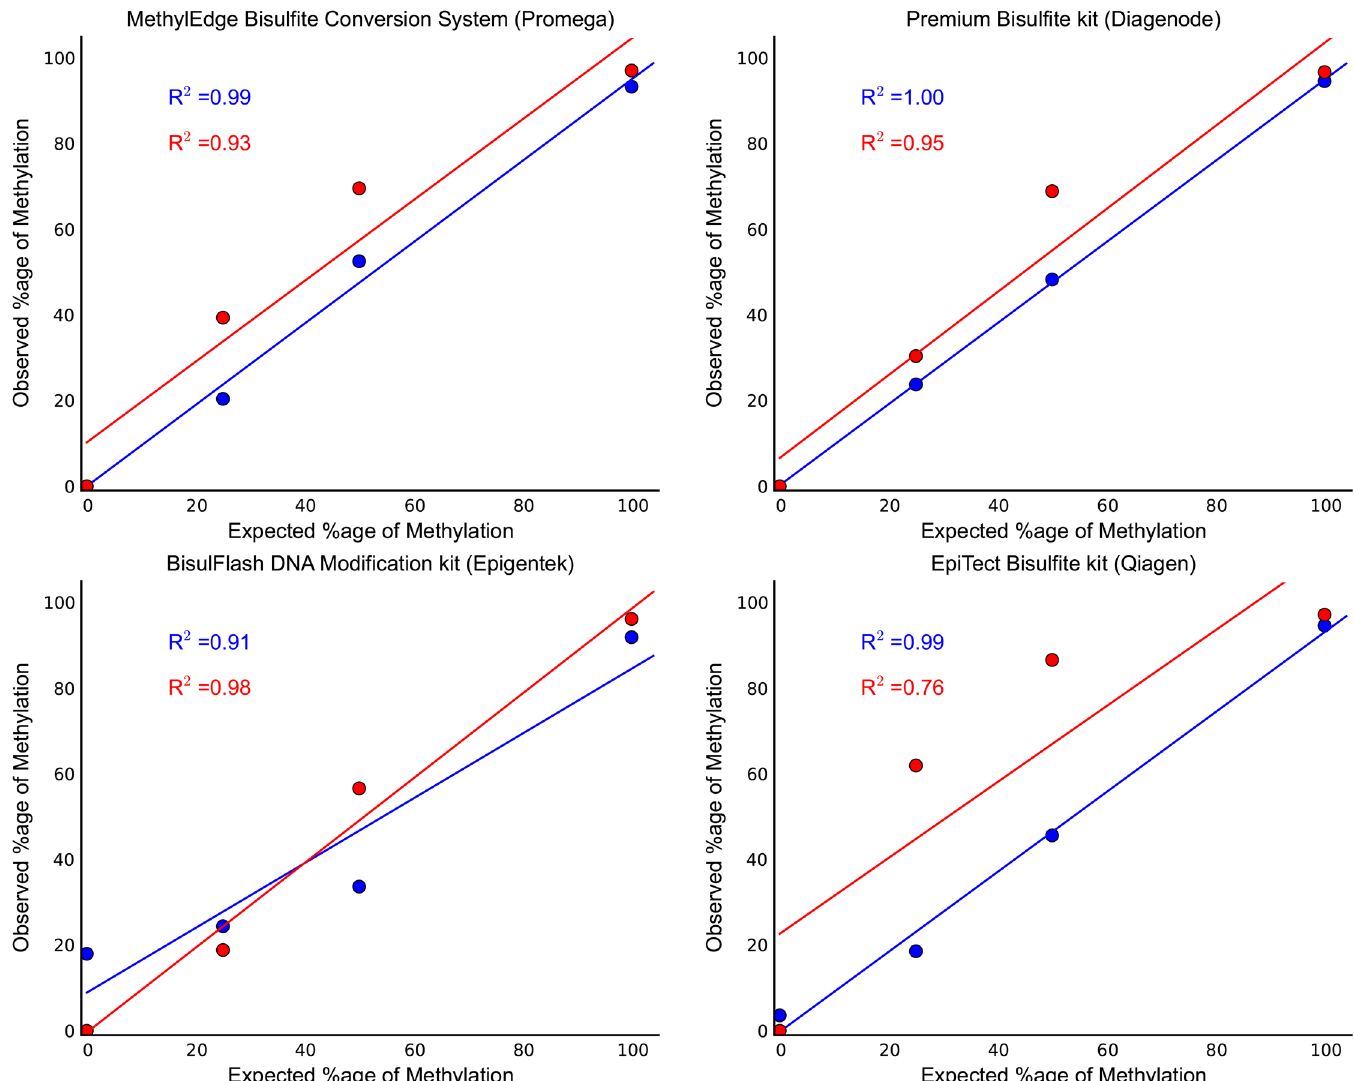
Fig 5. Bisulfite amplicon sanger sequencing. Standard curves were generated by sanger methylation quantification of known methylation level controls. The expected percentage of methylation was plotted versus the observed one. Points represent the mean methylation level of the fifteen and eleven CpG sites for the two regions, respectively, as analyzed with Sanger/ESME (blue line = Lambda control 1, red line = Lambda control 2). Both λ -DNA controls were able to fit linear lines with R 2 values as presented. The correlation coefficients are higher in the data generated from the Premium Bisulfite kit (Diagenode) and the MethylEdge Bisulfite Conversion System (Promega). [P value for i) Lambda control 2 (Qiagen) = 0.1309, ii) rest of samples < 0.05].